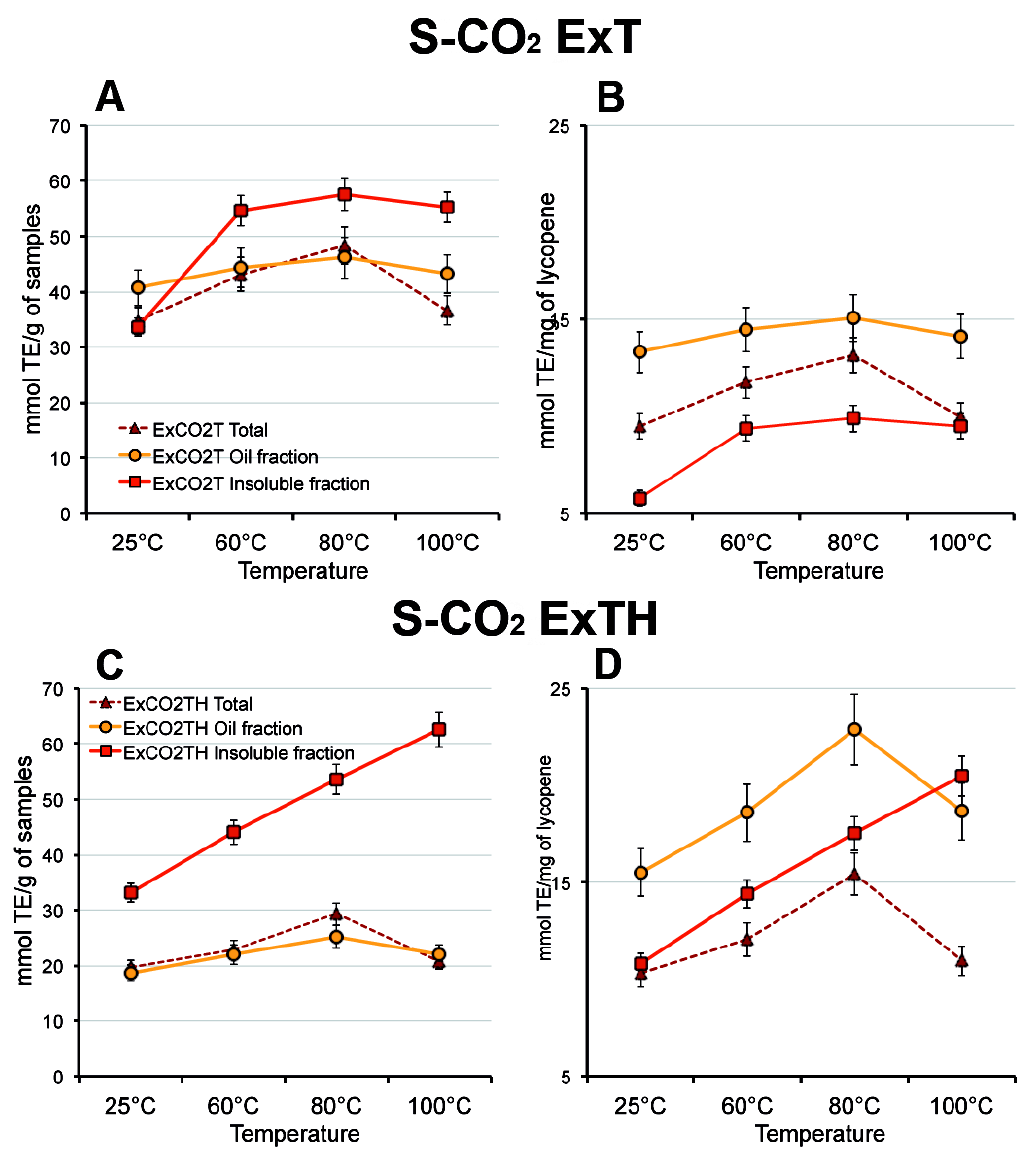
Figure 7. Effect of the temperature on antioxidant activity in the total extracts, oil- and insoluble-fractions of the S-CO extracted oleoresins. Antioxidant activity was expressed 2 as mmol of trolox equivalent (TE) per gram of sample ( A , C ) or per mg of contained lycopene ( B , D ). S-CO ExT: oleoresin extracted by S-CO from pure tomato powder; 2 2 S-CO ExTH: oleoresin extracted by S-CO from tomato powder added with hazelnut 2 2 powder. Data are mean ± SD of three measures from three independent